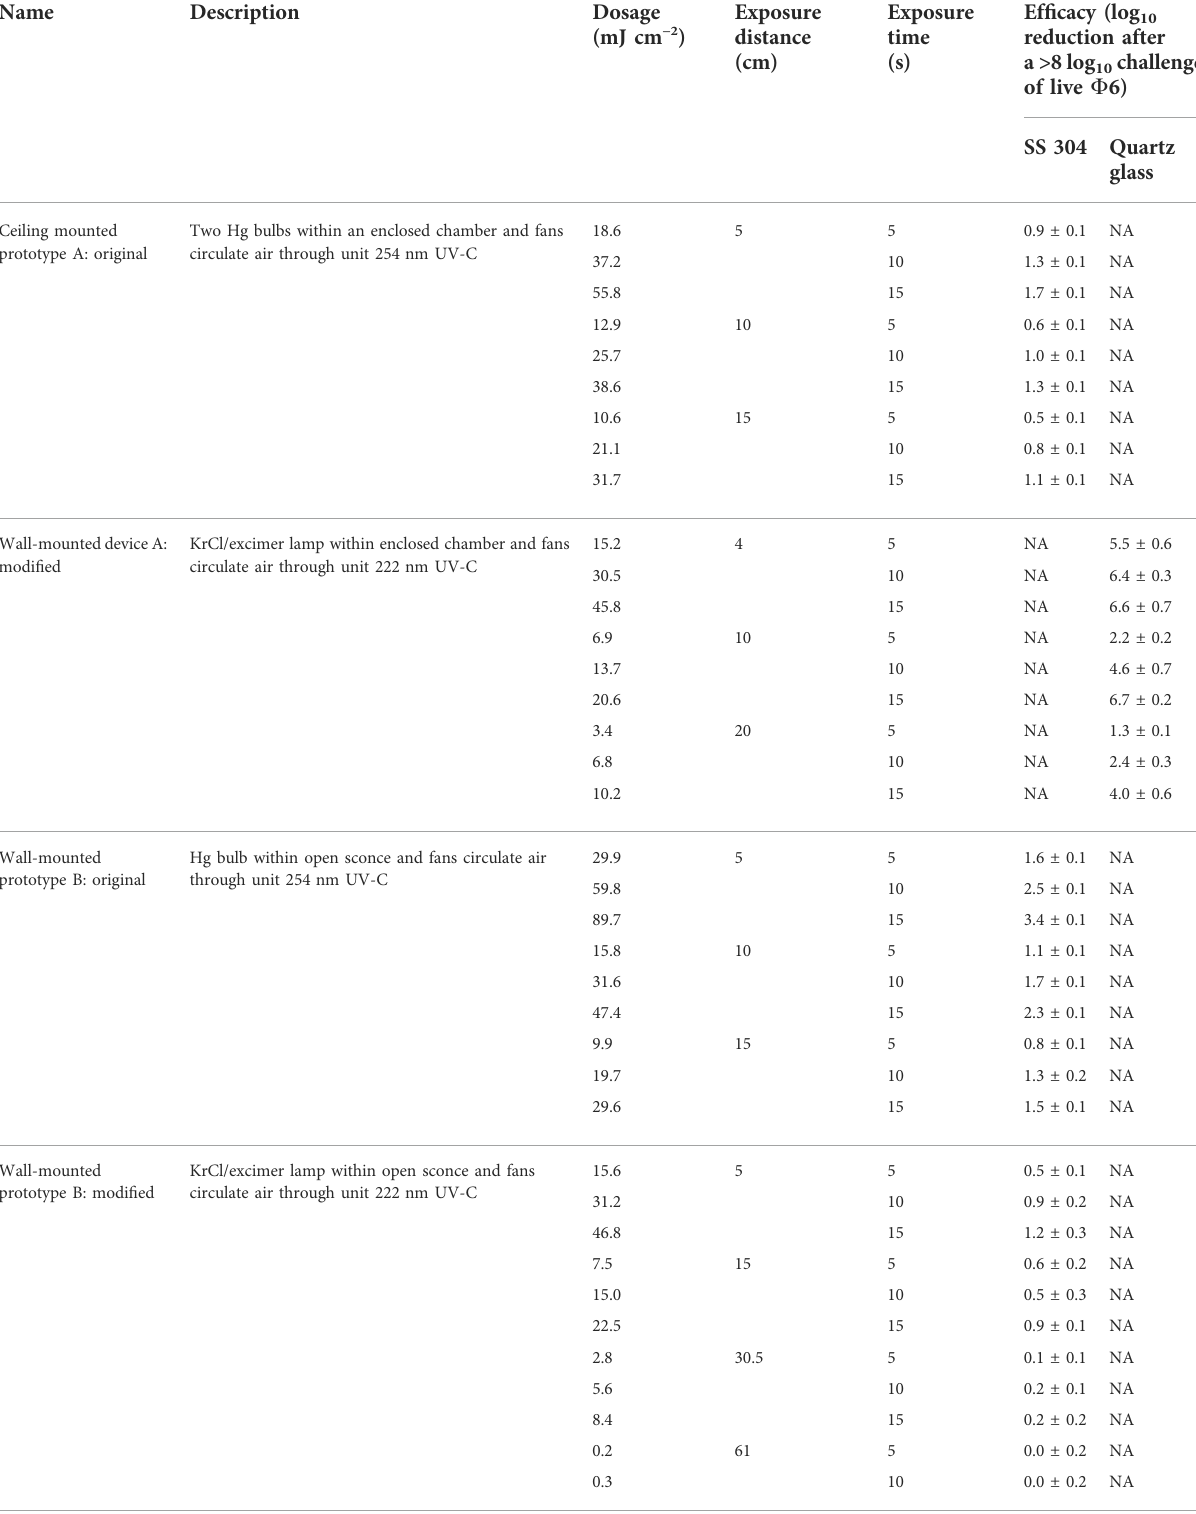
TABLE4Dosageandef fi cacyofroomair-irradiatingprototypesshowinglog 10 reductiondatabasedontheaveragepowerfromthebulbarea,notthe peaks. White (low decontamination) = Fail < 2 log 10 ; yellow (sanitation) = Fail ≥ 2 log 10 , < 3 log 10 ; light blue (disinfection) = Pass ≥ 3 log 10 ; and dark blue (approaching virus sterilization) = Pass ≥ 6 log 10 . N/A — dosage measurements had no meaning because of the broad-spectrum Xe